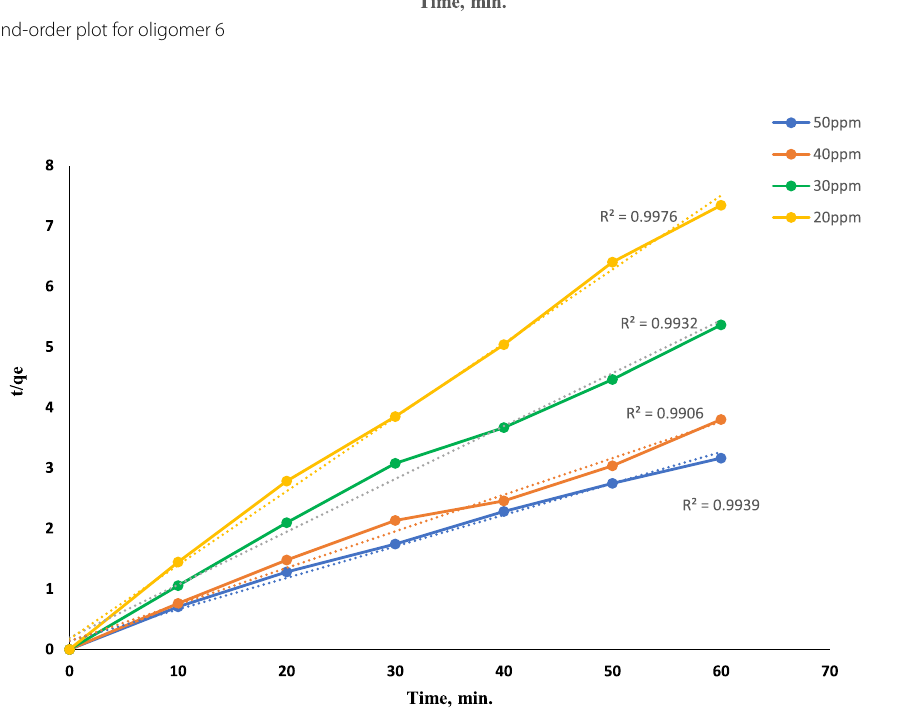
Fig. 10 Pseudosecond-order plot for composite